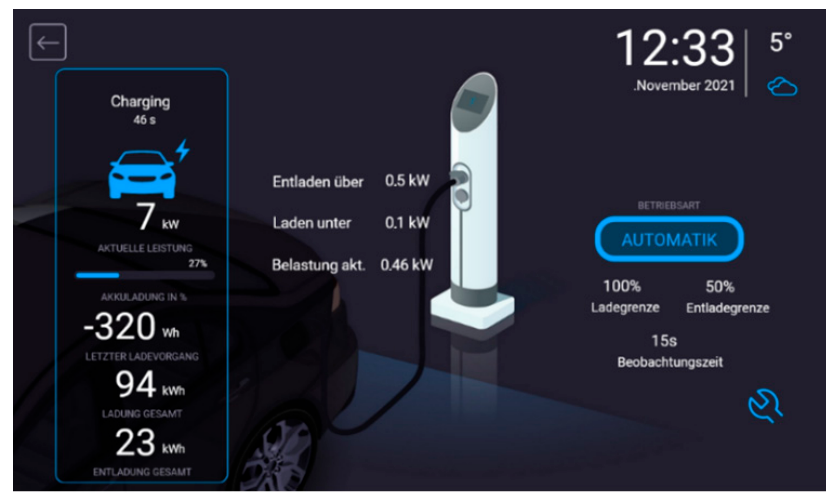
Figure 4. User interface to control the bidirectional EVSE via OCPP 1.6.